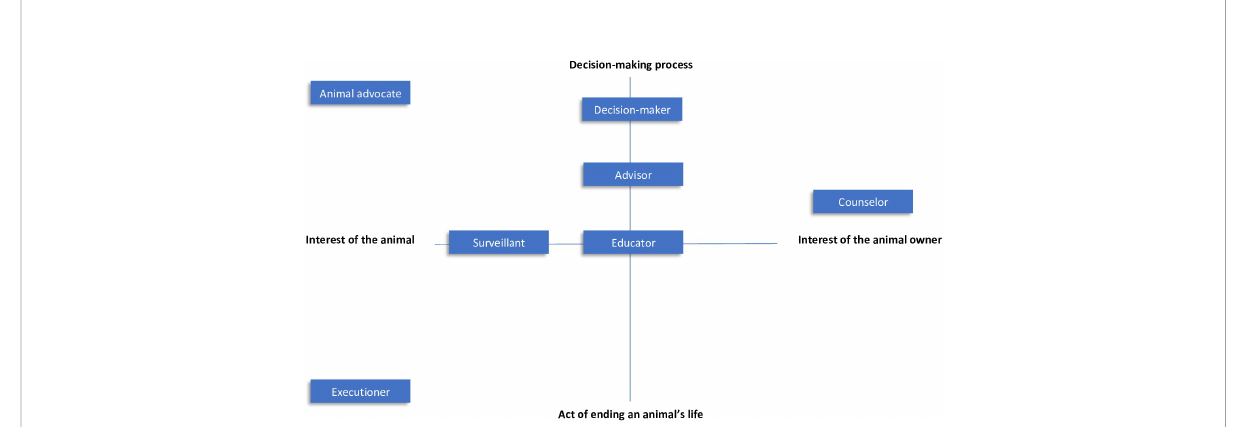
FIGURE 1 An overview of the roles veterinarians perceive in EoL situations. Underlying these roles are two contextual dimensions. On the vertical axis is the stage in which a veterinarian gets involved at the end of animal ’ s life, and on the horizontal axis are the interests taken into consideration and prioritized by the